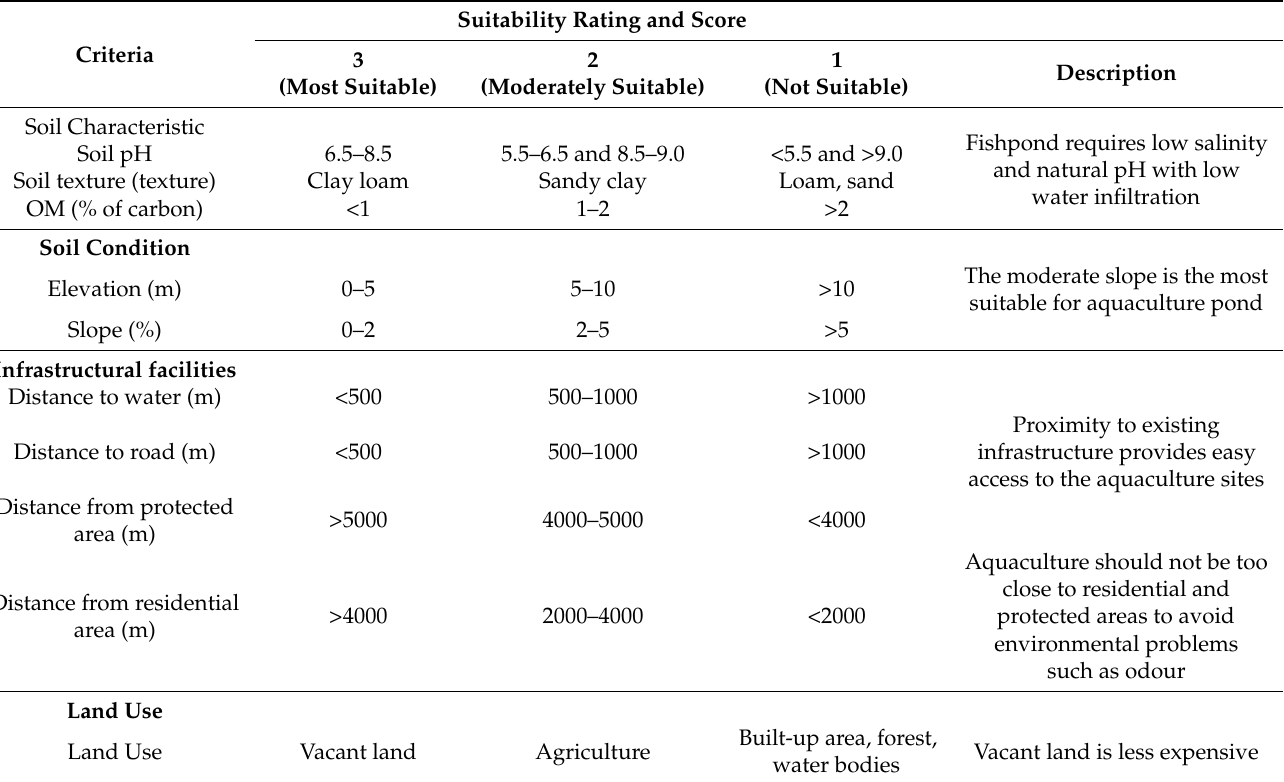
Table 2. The suitability rating for the aquaculture site selection criteria [26,30,32,35].